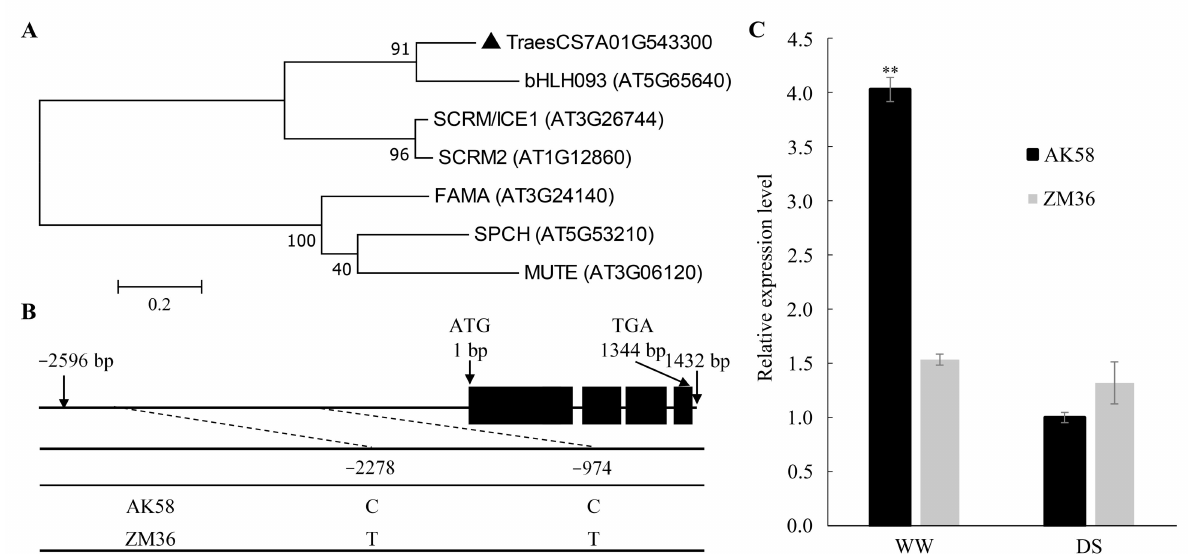
Figure 5. Candidate gene analysis. ( A ) Molecular phylogeny of TraesCS7A02G543300 and related bHLHs in Arabidopsis . ( B ) Schematic diagram of the TraesCS7A02G543300 structure. The ATG start codon was designated as position 1 bp. Polymorphic sites were detected in the promoter region of TraesCS7A02G543300 . ( C ) qPCR analysis of gene TraesCS7A02G543300 expression. Data represent means ± SE (n = 3). **, p <